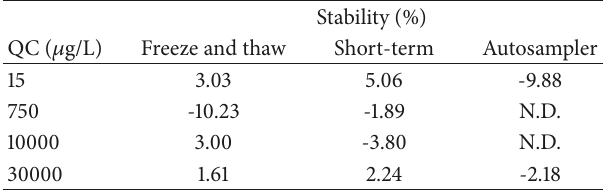
Table 3: Stability data for